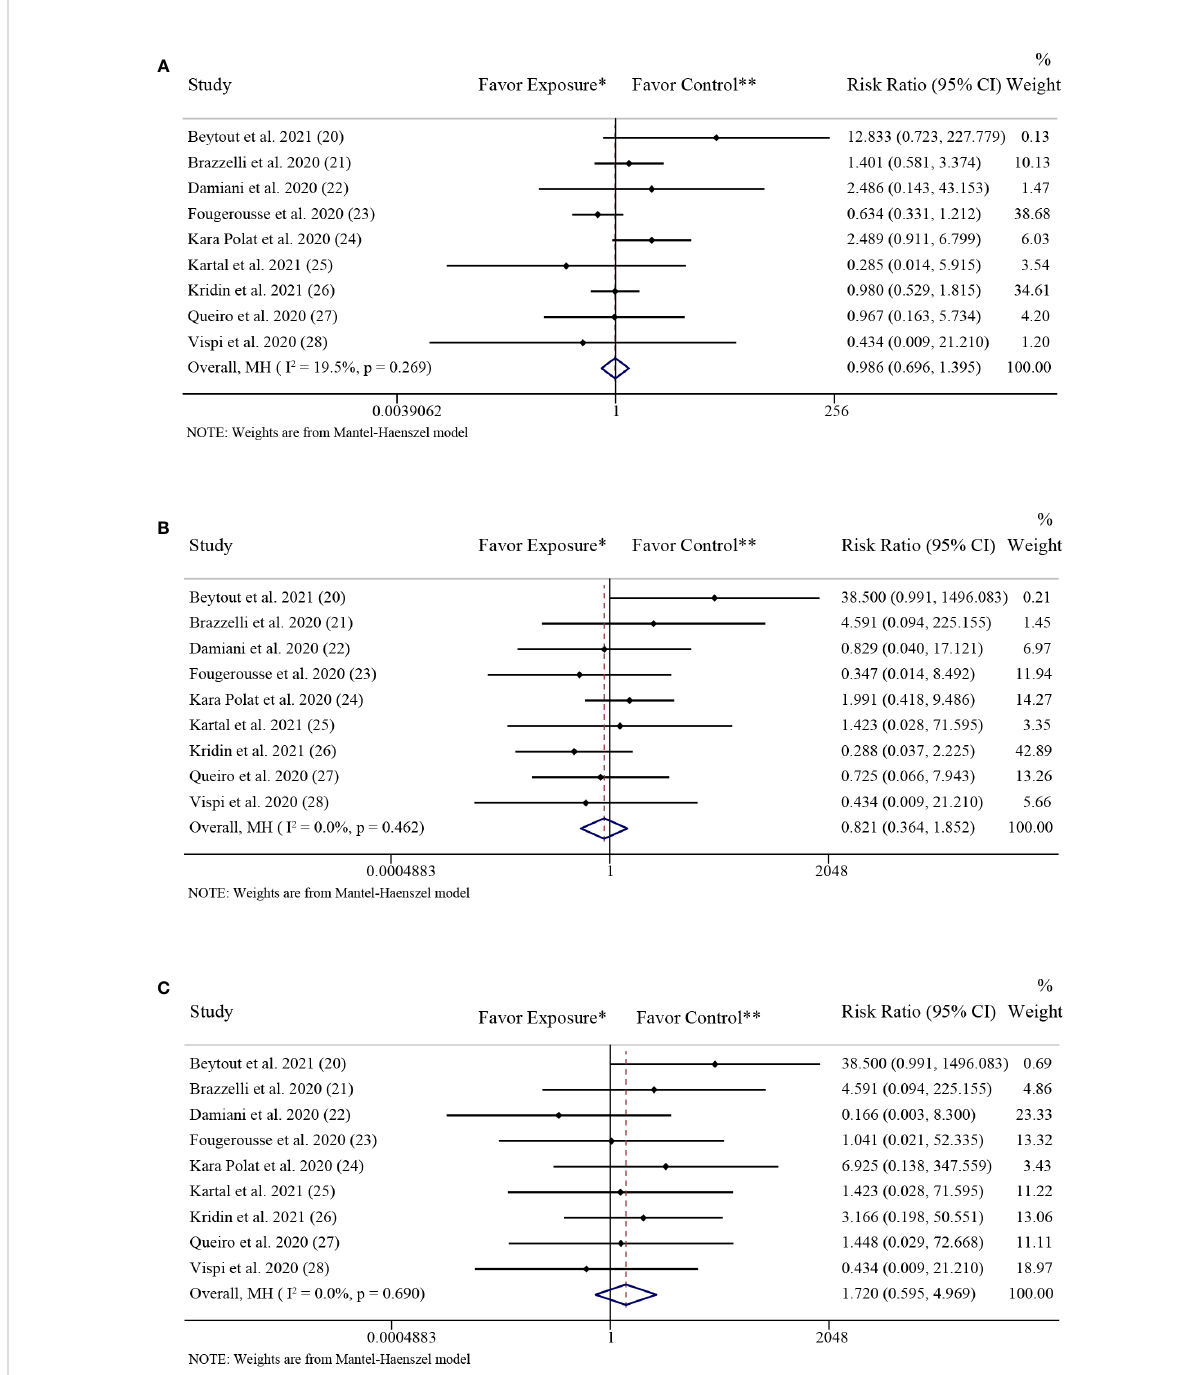
FIGURE 3 Forest plots of risk ratios and 95% con fi dence intervals. (A) Forest plot of risk ratios and 95% CIs of the SARS-CoV-2 infection rate; (B) Forest plot of risk ratios and 95% CIs of the COVID-19 hospitalization rate; (C) Forest plot of risk ratios and 95% CIs of the COVID-19 mortality rate. CI , con fi dence interval; COVID-19 , coronavirus disease 2019; MH , Mantel-Haenszel method. *Exposure represents patients with psoriasis treated with IL-17 inhibitors. **Control represents patients with psoriasis treated with